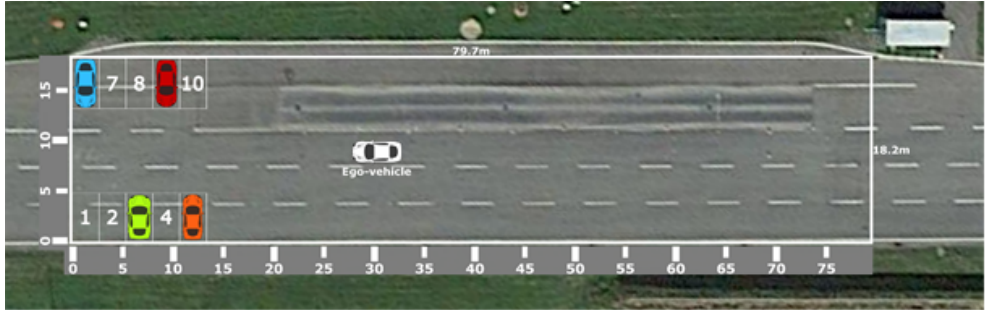
Figure 14. Parking scenario description of the PVLSA demonstrator validation test.